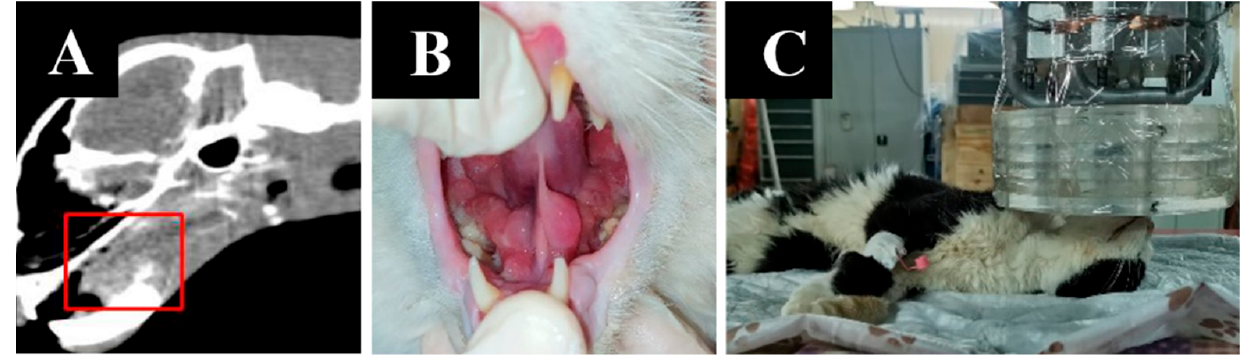
Figure 9. A cat named “Lucky”. ( A )—CT of soft tissues before irradiation. ( B )—the appearance of the tumor. ( C )—positioning of the animal during the irradiation session.